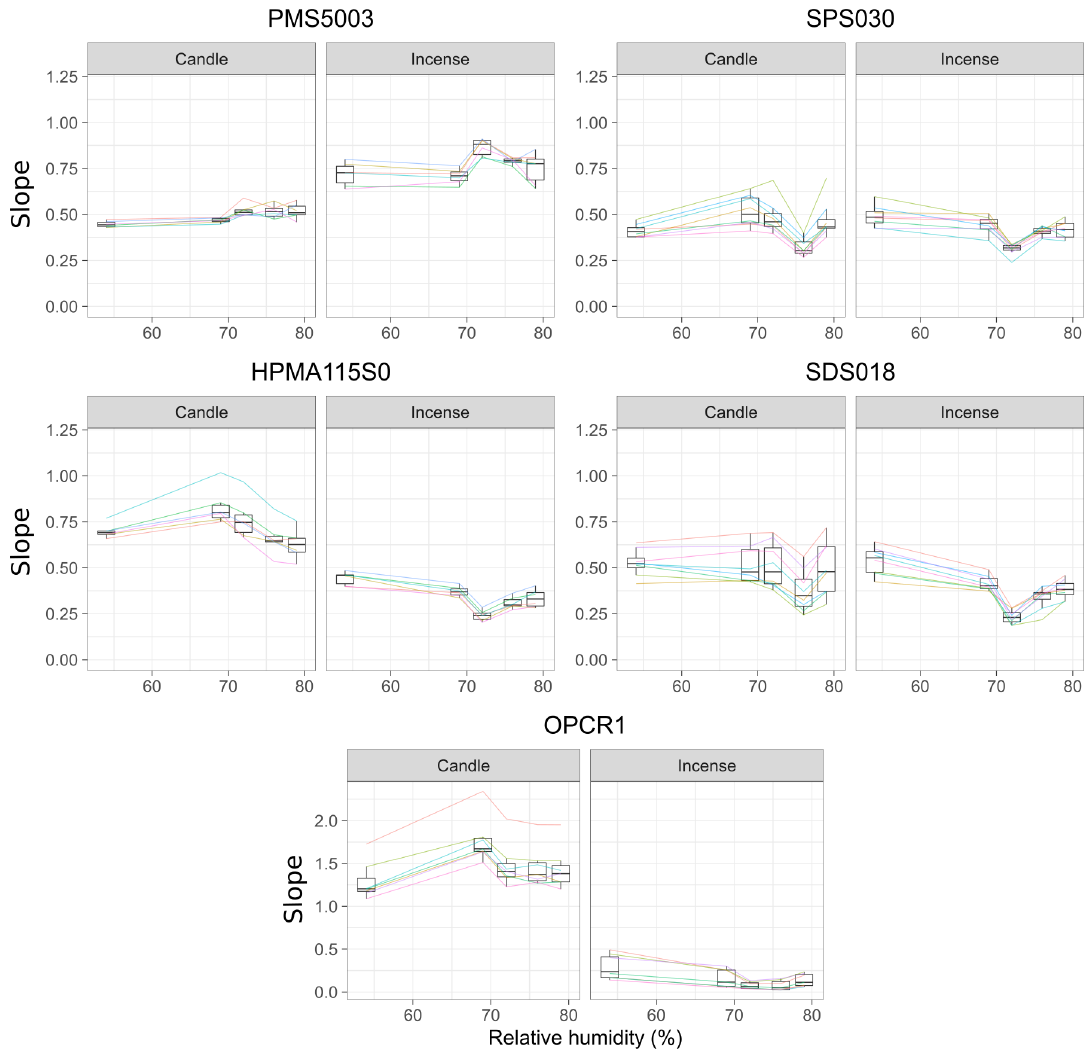
Figure 7. Slopes of the linear regression between the readings of the sensors and the DustTrak (y = sensor, x = DustTrak) for different level of relative humidity (each level of relative humidity corresponds to experiments 1 to 5), for candle and incense generated concentrations of PM 2.5 (peaks and stable concentrations not differentiated). For each graph, the colours correspond to the sensors of the model tested. The colours are consistent with Figure 6. Only the points with a p -value < 0.05 have been considered. The box and whisker plot horizontal lines represent, from bottom to top, the lower quartile, the median and the upper quartile. The vertical lines are drawn to the smallest and the largest data point that fall within 1.5 times the interquartile range below the lower quartile and above the upper quartile respectively. Values outside these range are considered as